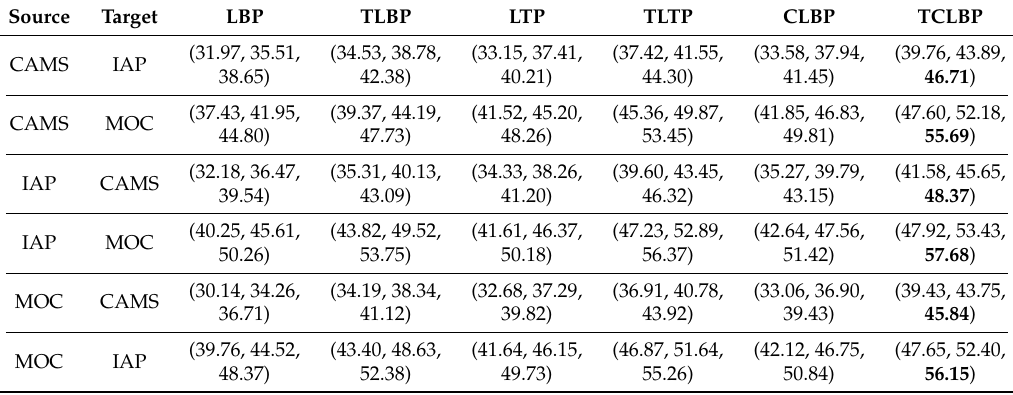
Table 3. Cross-domain classification accuracies (%) with different local features. The three accuracy numbers in a triple are the basic classification accuracy, the recognition accuracy after IGC, and after FN,